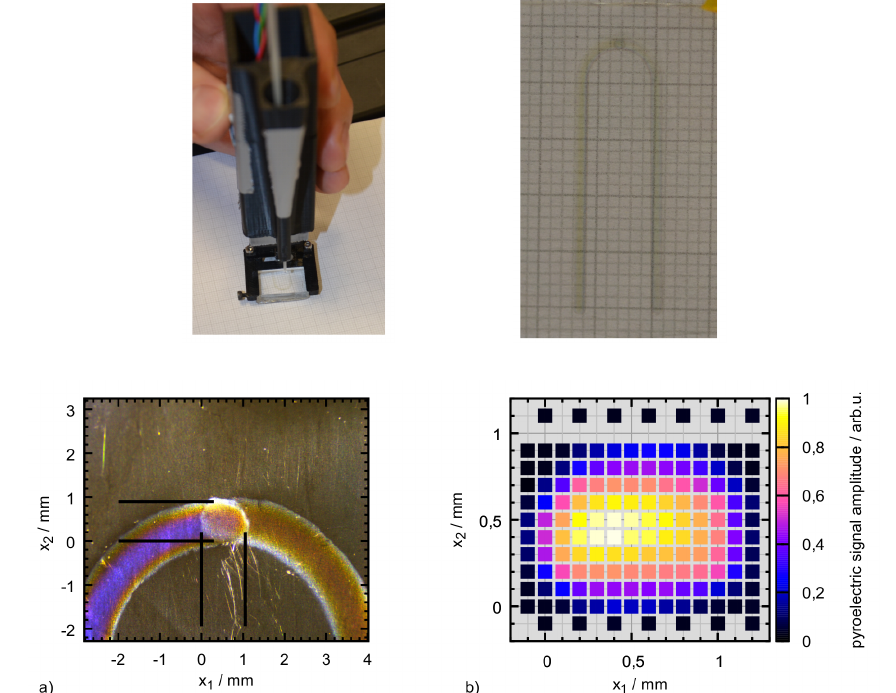
Figure 21. The top left panel shows a photograph of the optoacoustic hand-held device developed for clinical applications. An enlarged view of the sensitive element pre-mounting is shown in the top right panel. It lies on mm paper to get a better impression of size and transparency. The bottom row shows an enlarged view of the electrodes at top and bottom sides of the sensor film forming the active area by their overlap ( left ). The active area is confirmed by measurement of the pyroelectric effect induced by direct raster illumination of the electrodes on film through 150 × 150 µm apertures ( right ) (reproduced with permission from